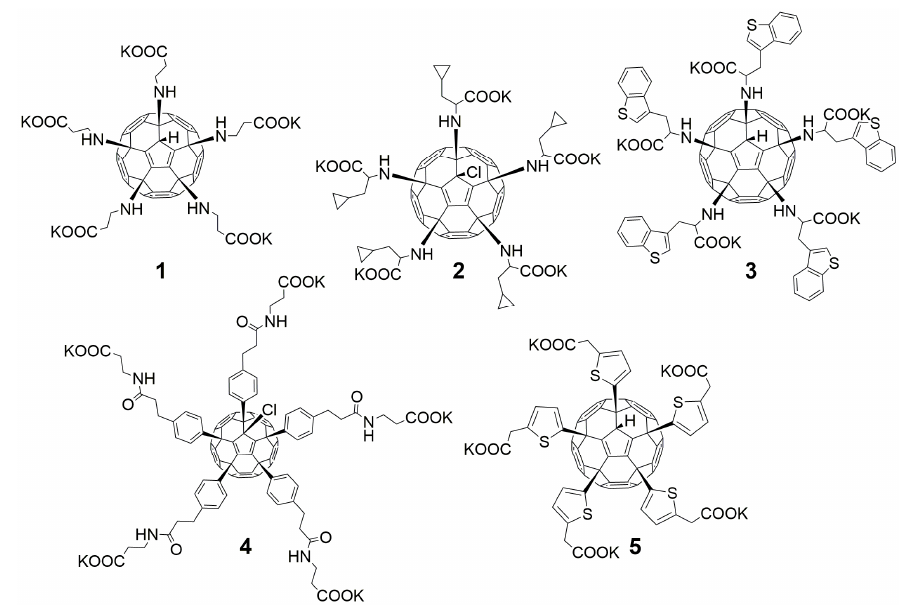
Figure 1. Molecular structures of water-soluble fullerene derivatives 1 – 5 .